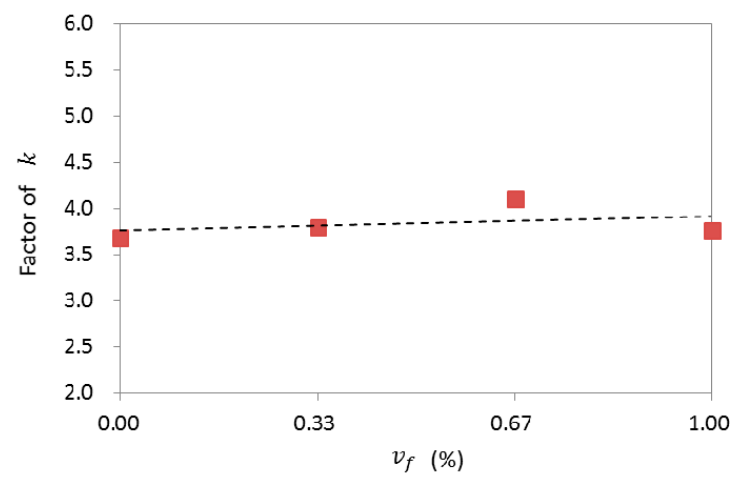
Figure 14. Variation in the factor 𝑘 with the change in the fiber volume percentages from zero to 1.00%.